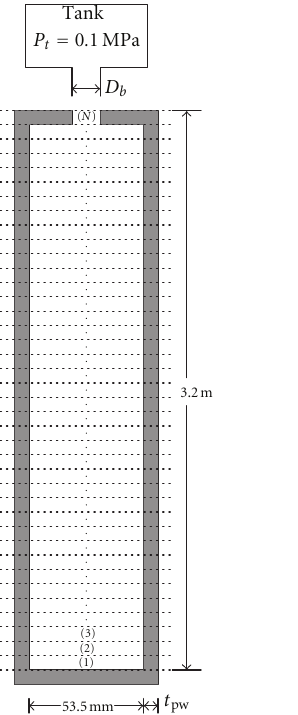
Figure 1: Sketch of the pipe section ( D b : break diameter, t pw : pipe wall thickness).